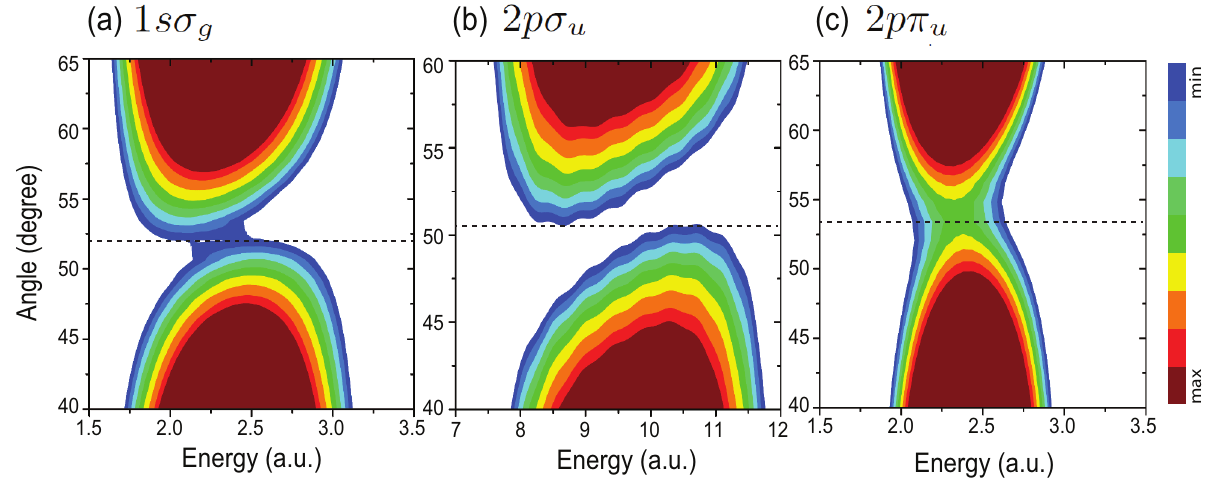
Figure 8. Angle θ resolved MAPES in ( a ) the 1 sσ electronic states of the x oriented molecular ion H + polarized attosecond XUV laser pulses at intensity I a.u.). The corresponding pulse wavelengths and durations are respectively (a) λ = 12 . 5 nm and T = 333 . 6 as, (b) λ = 4 . 25 nm and T = 113 . 4 as, and (c) λ = 15 nm and T = 402 as. Dashed lines denote the critical angles ϑ a logarithmic scale in arbitrary